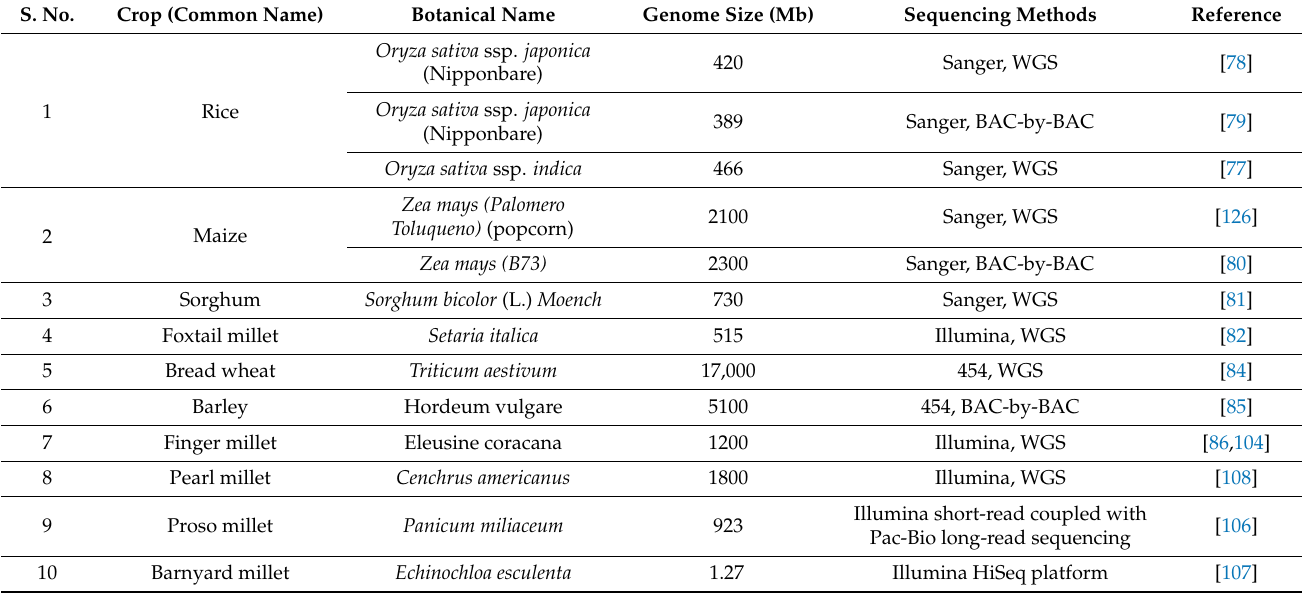
Table 1. List of important cereal crops